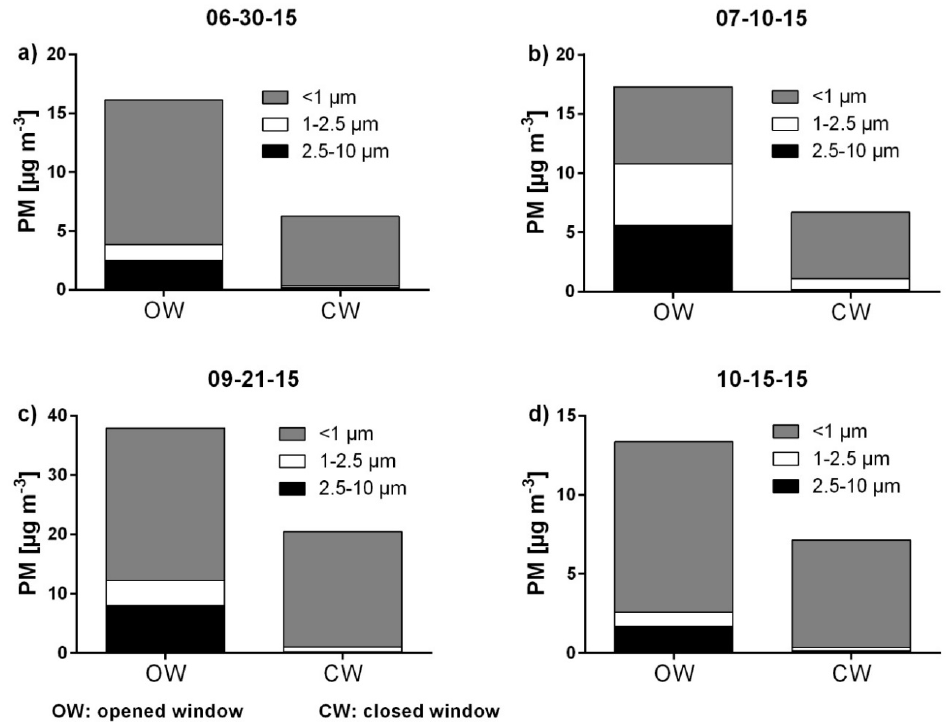
Figure 8. In ‐ cabin PM concentrations and particle size distributions measured with an opened and closed window. ( a ) On 06 ‐ 30 ‐ 15, ( b ) on 07 ‐ 10 ‐ 15, ( c ) on 09 ‐ 21 ‐ 15, ( d ) on 10 ‐ 15 ‐